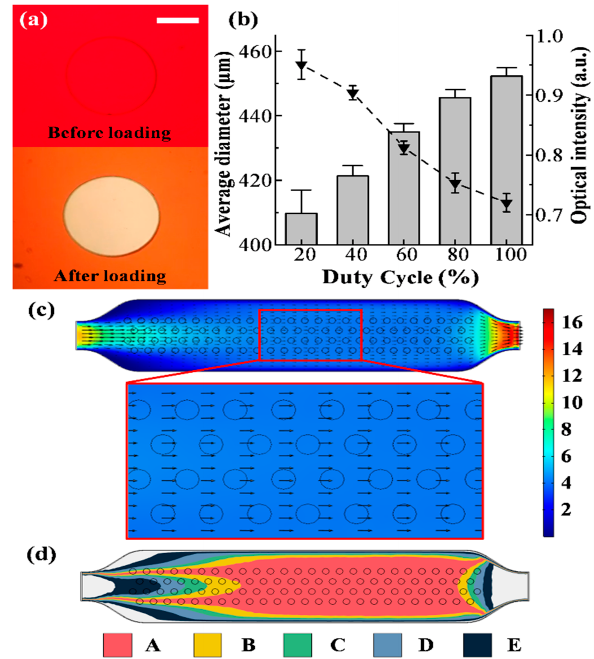
Figure 2. ( a ) Micrographs of the micro-pillar before and after loading stamp. Scale bar, 200 μ m. ( b ) Diameter created by stamping under a different duty cycle of the PWM wave in the electromagnet system, which generates magnetic force. The height of the chamber for different loads that were regulated by PWM obtained with the optical intensity measurement. ( c ) Distribution of velocity on the bottom of the chamber while inlet flow rate was 10 mL/min via the simulation. The direction of the arrow represents the flow direction of the fluid at the point. (Unit of scale: dyne/cm 2 ) ( d ) The relative error distribution of the shear stress on each cell-free zone at the bottom in conditions of a 10 mL/min inlet flow rate. (A, B, C, D, and E represent areas less than 10%, 20%, 30%, 50%, and 80%, respectively) via the